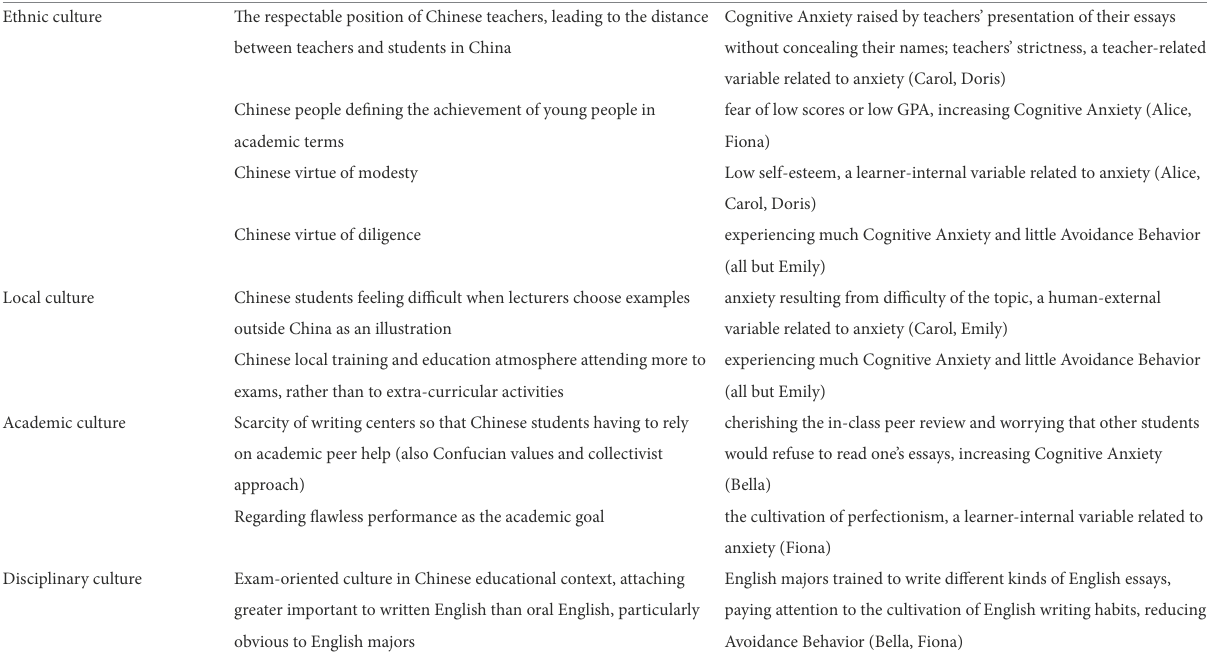
TABLE 3 Cultural influences on